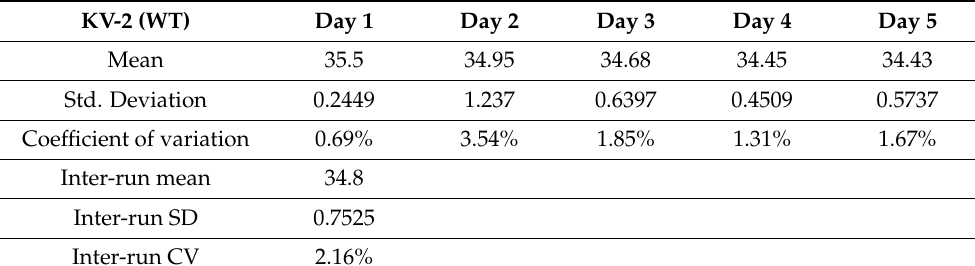
Table 8. Repeatability and reproducibility of the KV-2 assay.